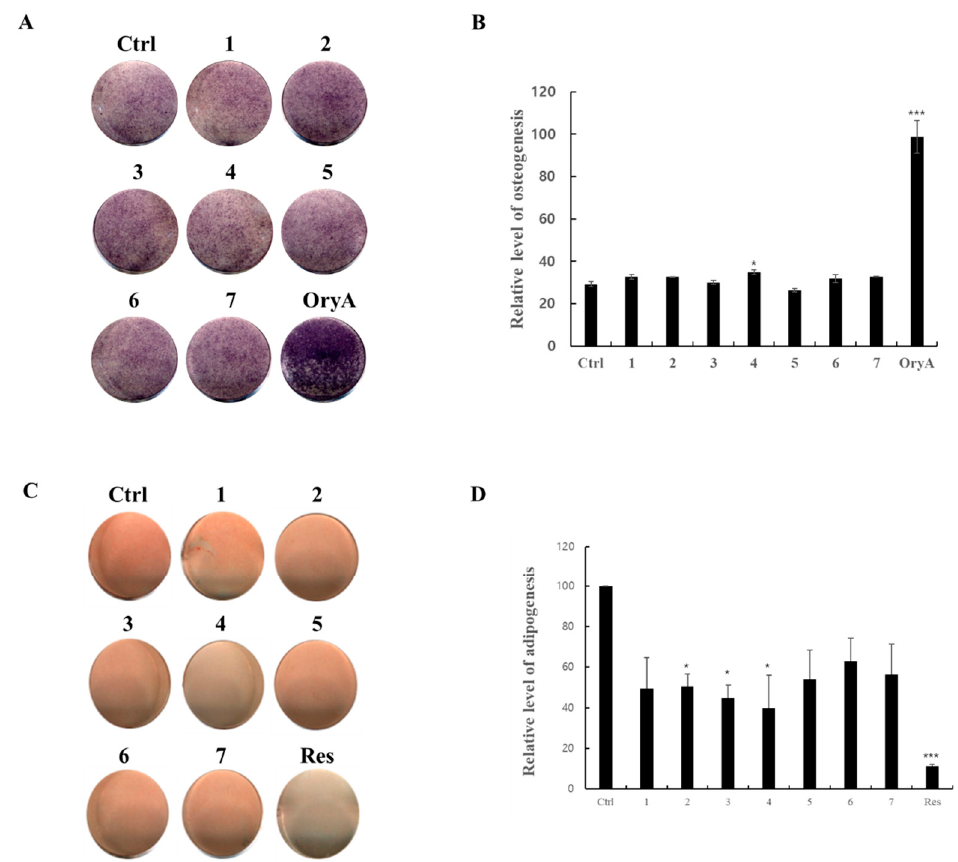
Figure 4. The effects of compounds 1 – 7 on the differentiation of MSCs toward osteoblasts or adipocytes. The mouse mesenchymal stem cell line, C3H10T1/2, was treated with compounds 1 – 7 . After osteogenic differentiation, the cells were stained with ALP ( A ) and ALP enzyme activity was measured ( B ). In the separate plates, the cells were differentiated into adipocytes prior to ORO staining ( C ). Stained cells were quantitatively evaluated by resolving stained lipid droplets and measuring absorbance at the red wavelength ( D ). Ctrl represents untreated negative control. 5 µ M of oryzativol A (OryA) was added to the experimental set as a positive osteogenesis control. 20 µ M of resveratrol (Res) was used as a positive control in adipogenesis. 10 µ M of each of the compounds was added to the osteogenesis- or adipogenesis-differentiation medium. * denotes p < 0.05 and *** denotes p < 0.001.